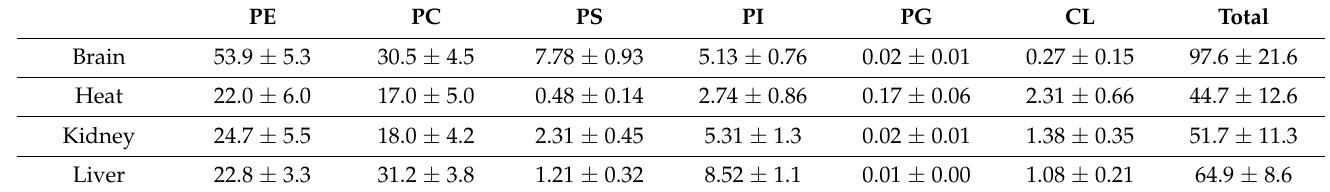
Table 1. Concentration of different phospholipids in the brain, heart, kidney, and liver of rats (nmol/mg, n = 4). Reprinted with permission from Ref. [39]. Copyright 2021, Springer Nature and